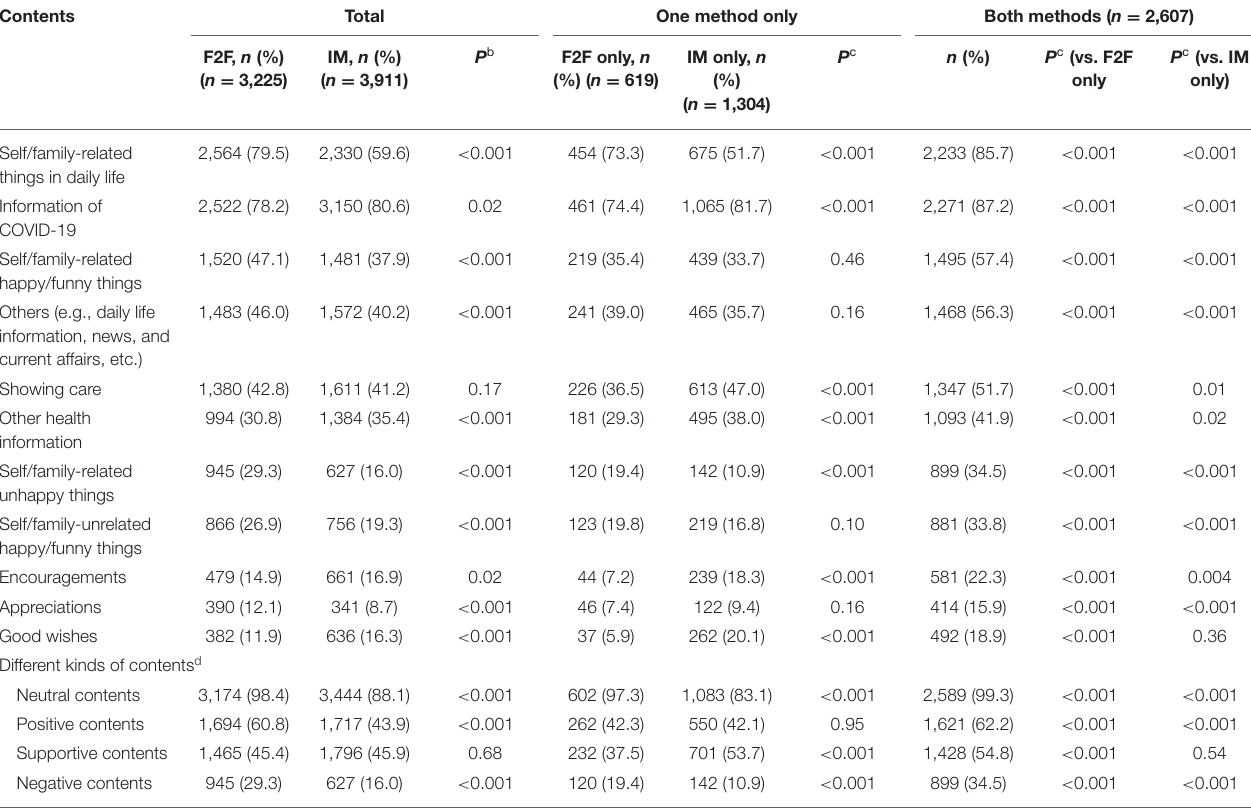
TABLE 2 | Weighted percentages of contents by communication methods a